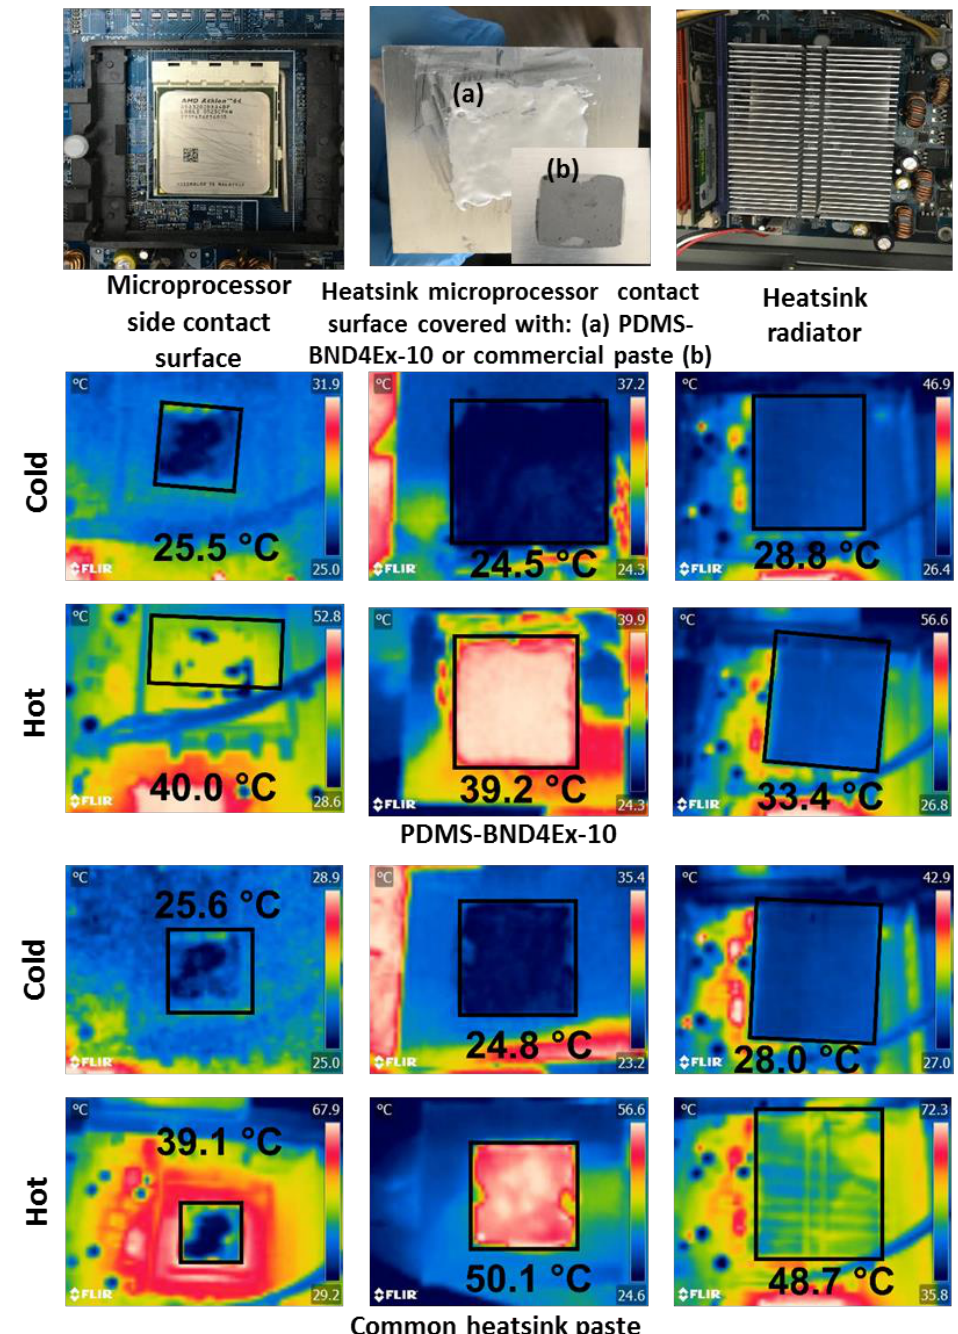
Figure 11. IR camera images and temperatures of the cooling surfaces tested for heat conduction of PDMS-BND4Ex-10 composite, as compared with commercial heatsink paste.